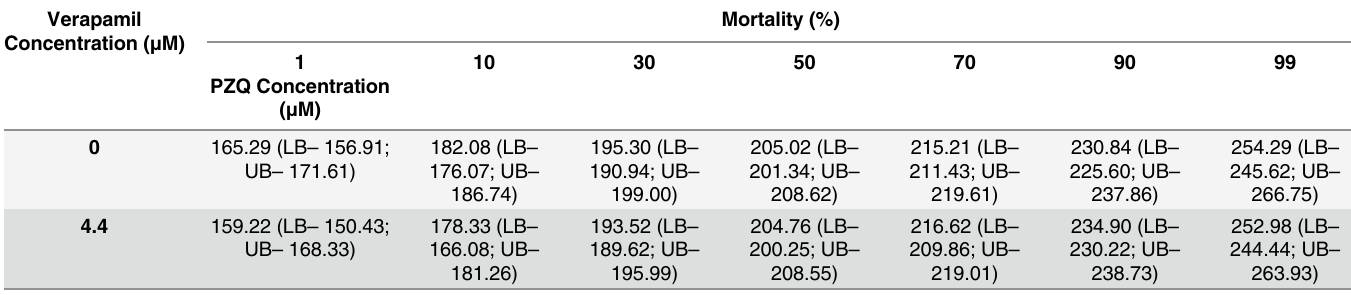
Table 4. Lethal doses of PZQ (LB — Lower Bound; UB — Upper Bound) calculated using Probit regression model with a 95% confidence, for S . man- soni PZQ-susceptible parasite strain females in the presence of different concentrations of Verapamil. Verapamil Concentration ( μ